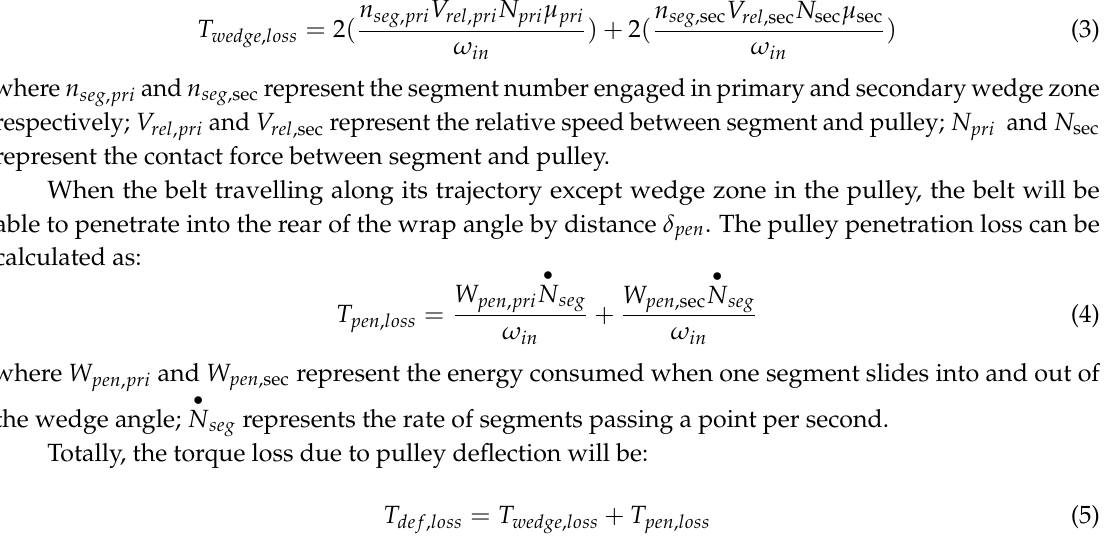
Figure 3. Geometry of a deformed pulley.